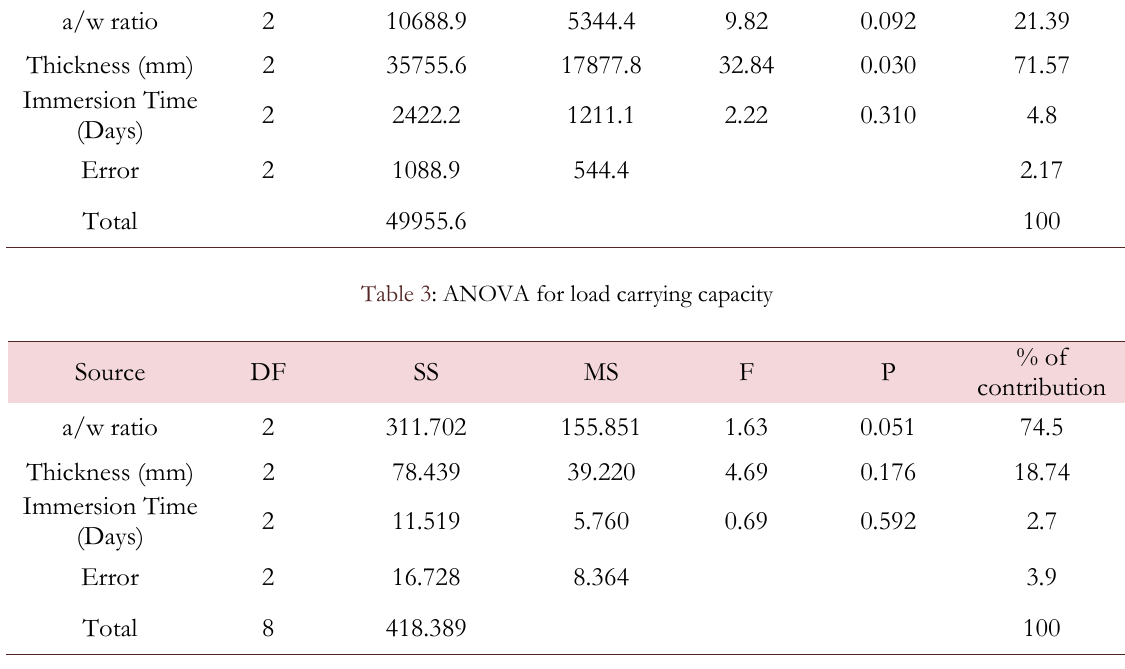
Table 4: ANOVA for Fracture toughness MPa